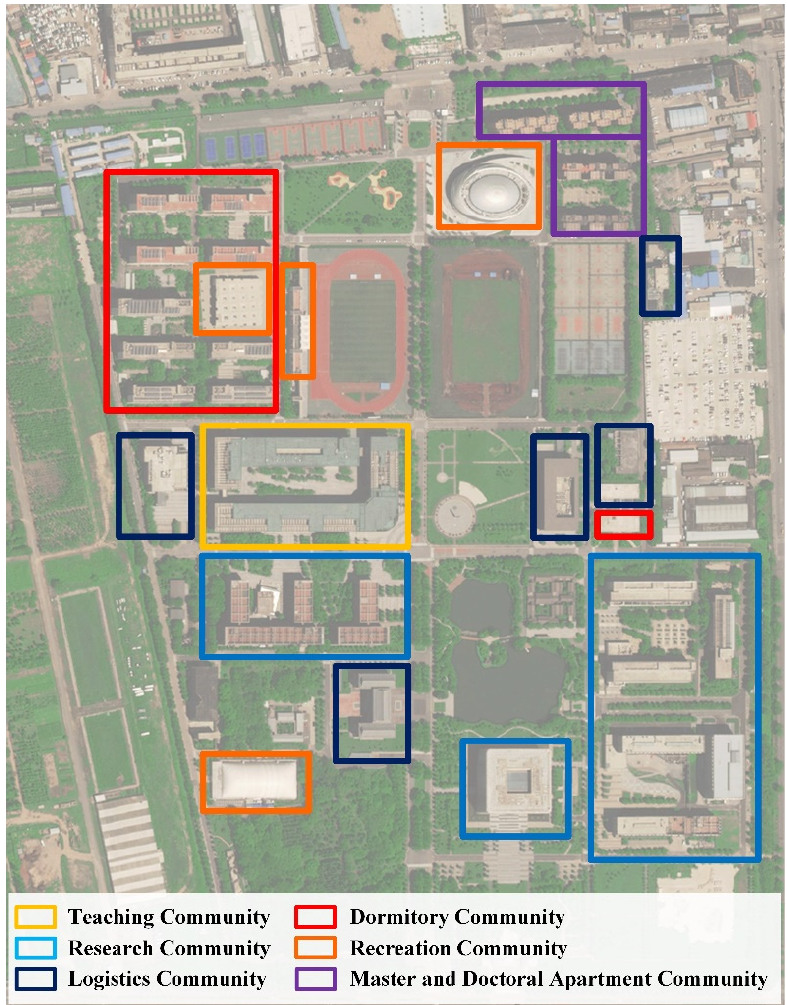
Figure 1. The university in Beijing taken as the study area.